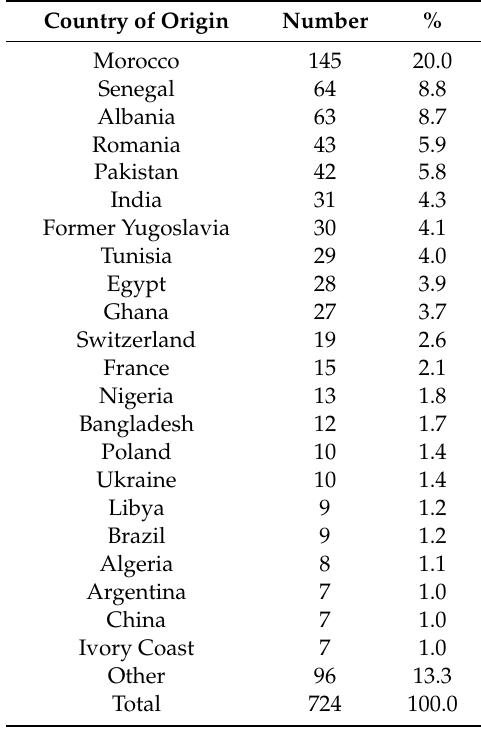
Figure 1. Number of migrant workers assessed at an occupational health public service from January 2001 to June 2013 ( n = 724 subjects). Table 1. Assessed migrant workers’ main countries of origin.